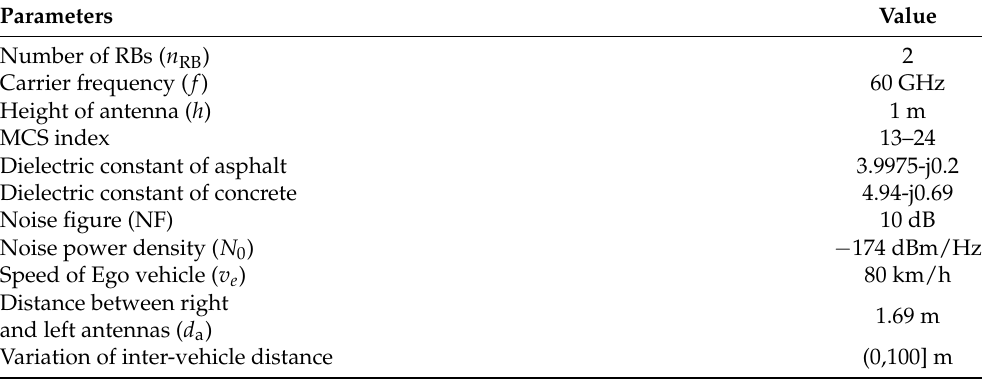
Table 2. Simulation parameters for V2V relay